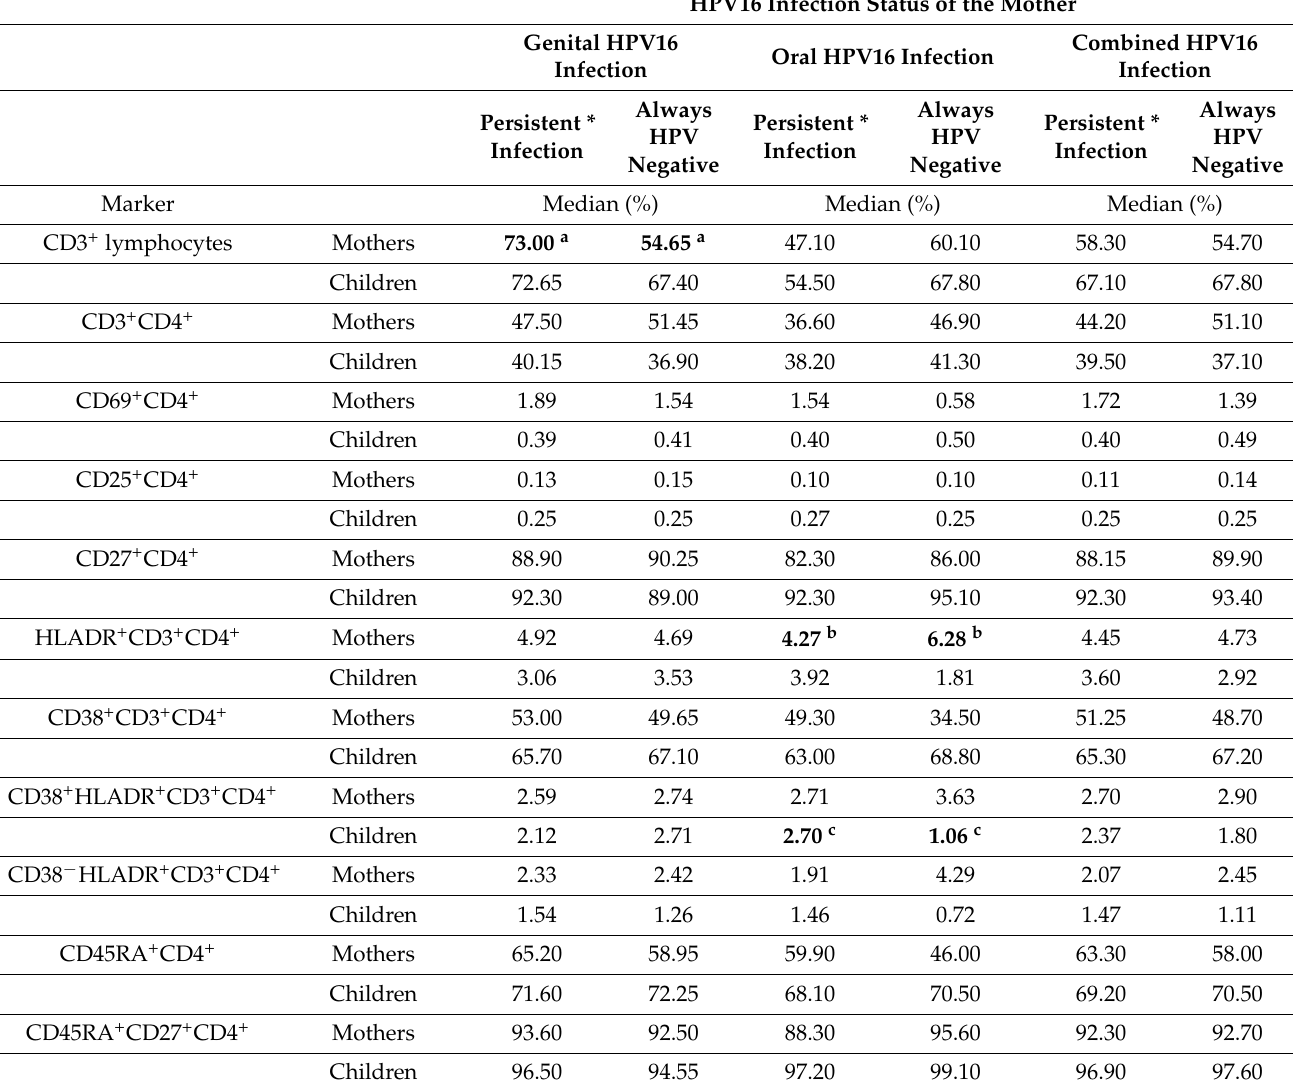
Table 3. CD4+ T-cell immunophenotypic subset distribution of the mother–child pairs stratified according to mother’s genital and oral HPV status. Significant median comparisons between the subgroups are